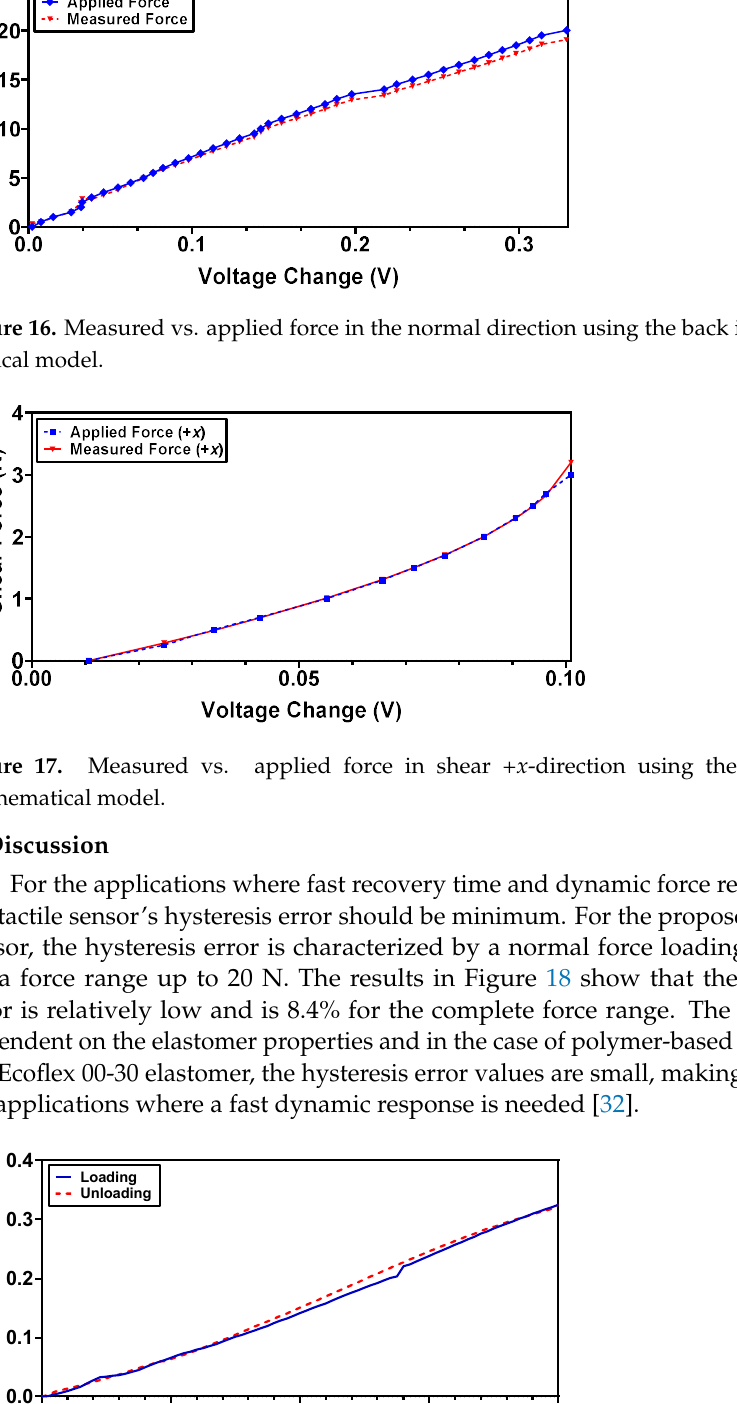
12 of 17 Figure 15. Dynamic response of the proposed magnetic tactile sensor for a force of 20 N at 4 Hz in the normal direction. 4.3. Force Calculation Based on the Experimental Data To measure the forces in the robotic surgical applications the output of the sensor which is in the form of voltage needs to be converted to force. Hence, the proposed mag- netic tactile sensor needs to be calibrated for a complete range of applied forces. For this purpose, a set of polynomial equations are derived by curve fitting a second-order poly- nomial expression on the output voltage data. From the recorded data the coefficients of polynomial expression are derived and the input forces are estimated using the coeffi- cients of the polynomial expression in the quadratic formula with the measured voltage values. The second-order polynomial equations for the force estimation in the normal and shear axis are given as: